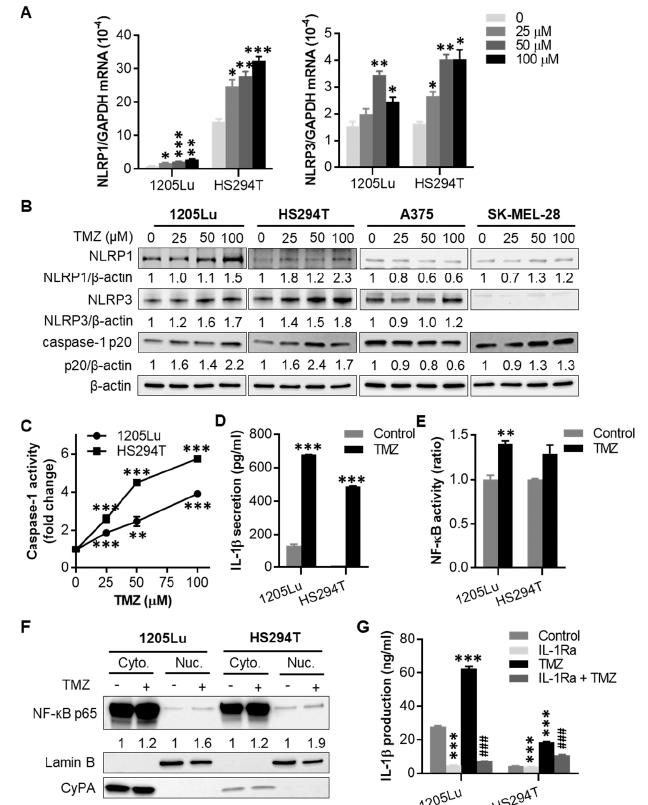
Figure 2. Effects of TMZ on NACHT, LRR and PYD domains-containing protein (NLRP) expression and inflammasome activation. Where indicated, cells were treated with a single dose of TMZ for 48 h, then tested for ( A ) NLRP1 and NLRP3 mRNA expression by qRT-PCR, ( B ) NLRP1 and NLRP3 protein expression, as well as cleaved caspase-1 (p20 form) by Western blot, and ( C ) caspase-1 activity by fluorochrome-labeled inhibitors of caspases (FLICA) apoptosis assay. In ( B ), the band densities were quantitated and normalized to those of the corresponding loading control β -actin subjected to the same treatment. ( D ) Interleukin-1 β (IL-1 β ) secretion analyzed by enzyme-linked immunosorbent assay (ELISA) from cells treated with 100 µ M TMZ for 48 h. ( E ) Nuclear factor- κ B (NF- κ B) activity in cells treated with 100 µ M TMZ for 48 h, determined using the Ready-to-Glow Secreted luciferase assay. ( F ) Western blot analysis of intracellular localization of NF- κ B p65 in cells treated with 100 µ M TMZ for 48 h. Cytoplasmic and nuclear fractions of cells were isolated and assayed for NF- κ B p65 expression. Cyclophilin A (CyPA) and Lamin B were used as markers for cytoplasmic and nuclear proteins, respectively. The band densities of NF- κ B p65 were quantitated and normalized to those of the corresponding loading control. ( G ) Intracellular IL-1 β production analyzed by ELISA from cells treated with 100 µ M TMZ and / or 10 µ g / mL IL-1 receptor antagonist (IL-1Ra) for 48 h. Data are representative of two independent experiments, and are expressed as the mean ± SEM ( n = 3). * p < 0.05, ** p < 0.01, and *** p < 0.001 vs the corresponding vehicle control. ### p < 0.001 vs the TMZ alone